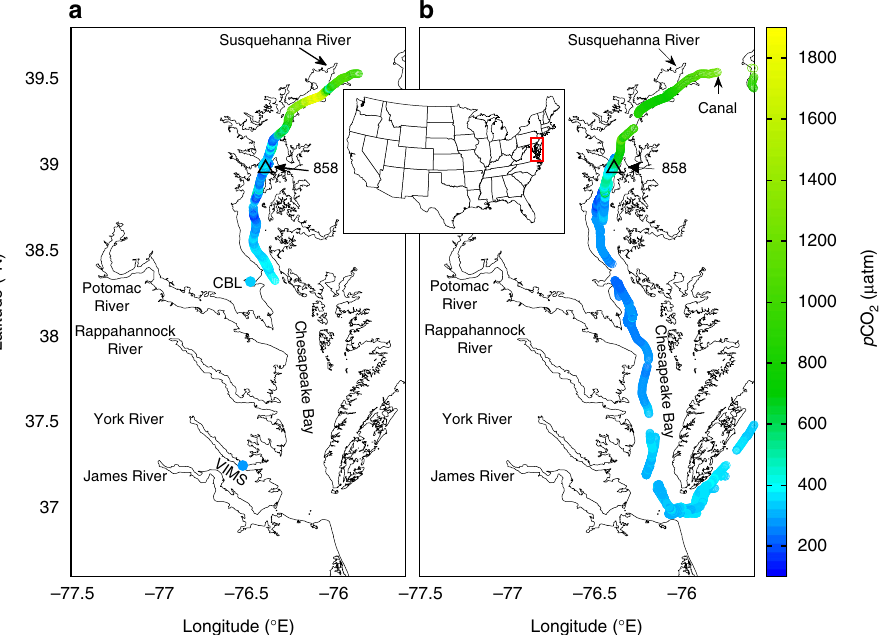
Fig. 1 Measured surface water p CO 2 overlapped on a site map of the Chesapeake Bay. a 8 – 15 August 2013 and b 11 – 16 April 2015. Data were collected underway aboard R/V Sharp and supplemented with dockside measurements at the Chesapeake Biological Laboratory ( CBL ) and Virginia Institute of Marine Science ( VIMS ) during the August cruise. The inserted map shows the general location of the bay. Station 858 is our focused study site. The cruise average of atmospheric and surface water p CO 2 values and monthly wind speed are given in Table 1. The p CO 2 range was 340 – 590 µ atm near CBL and 290 – 550 µ atm near VIMS, with the lower ends represent incoming bay water during high tides and the high ends representing outgoing